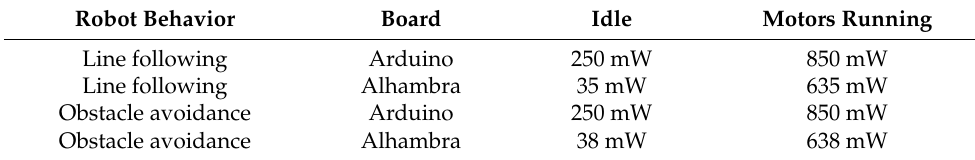
Table 3. Power consumption for reconfigurable computing and software approaches.